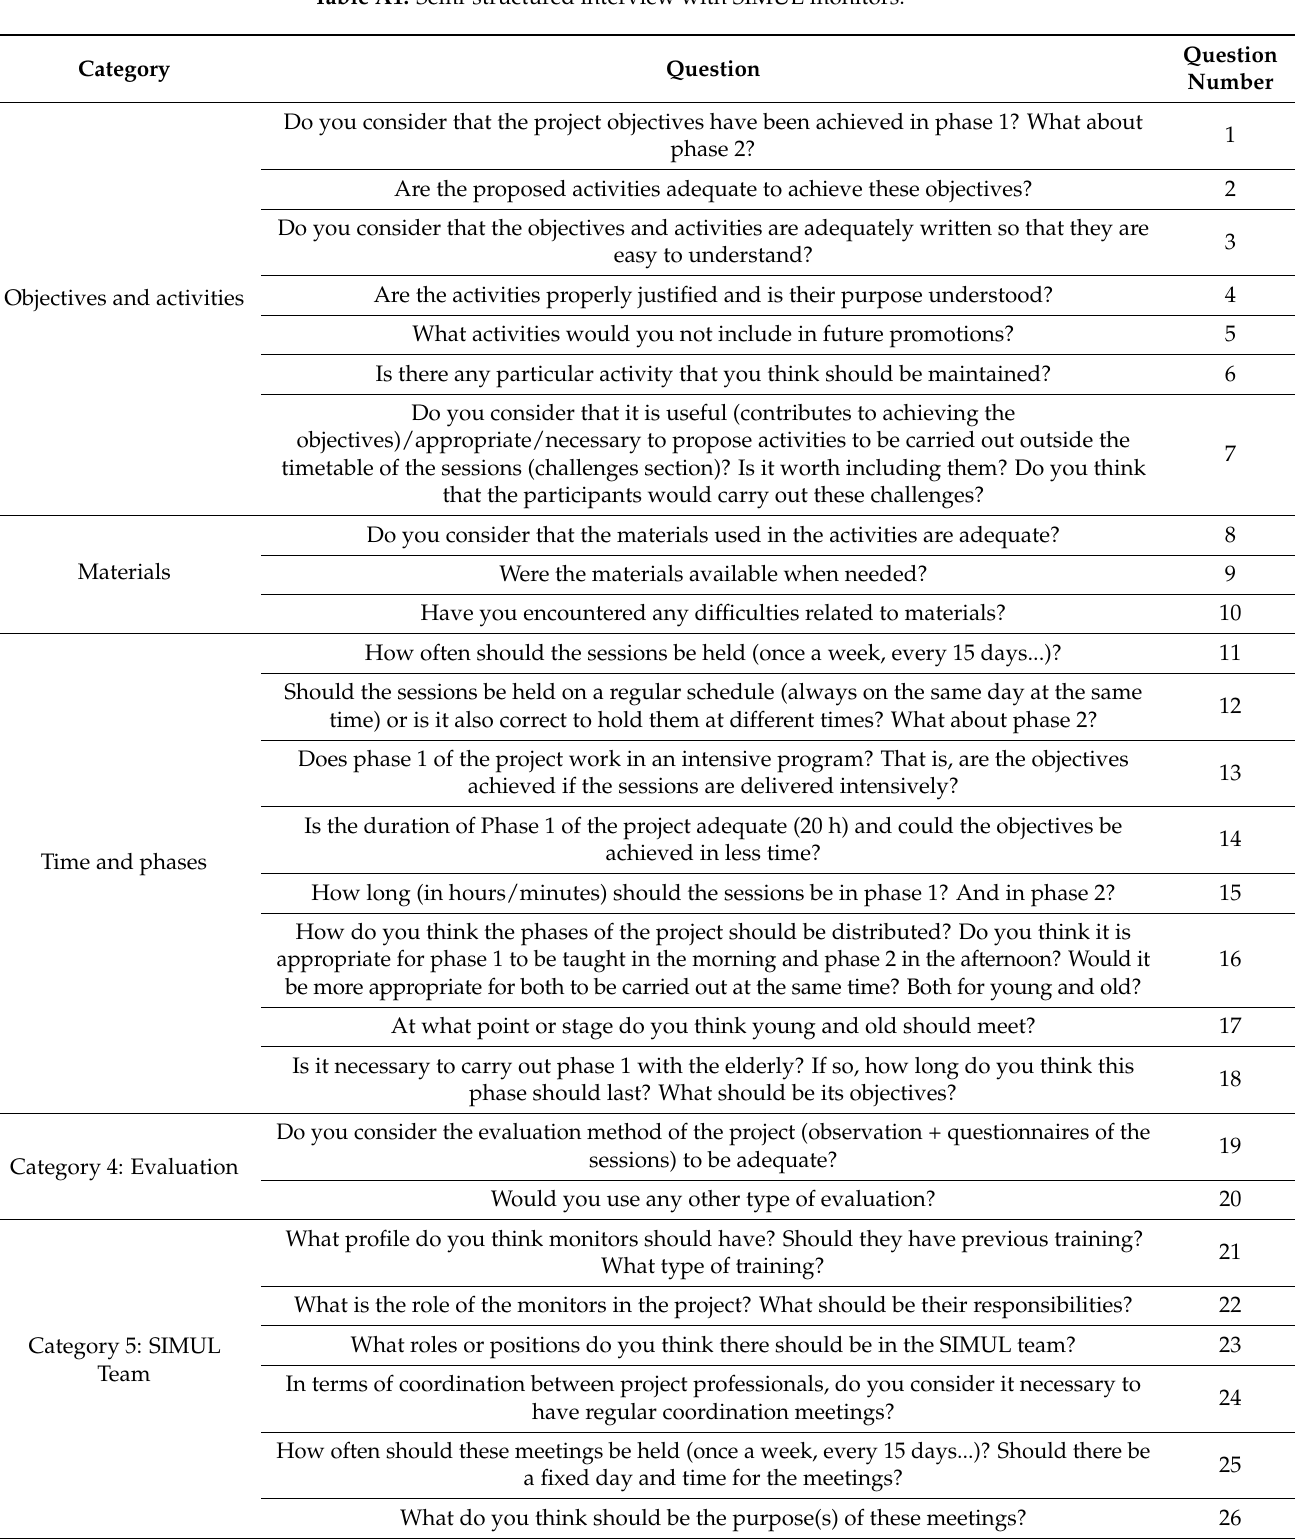
Table A1. Semi-structured interview with SIMUL